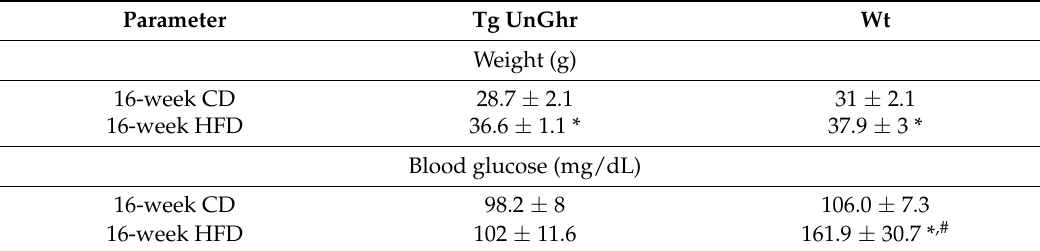
Table 1. Characteristics of study